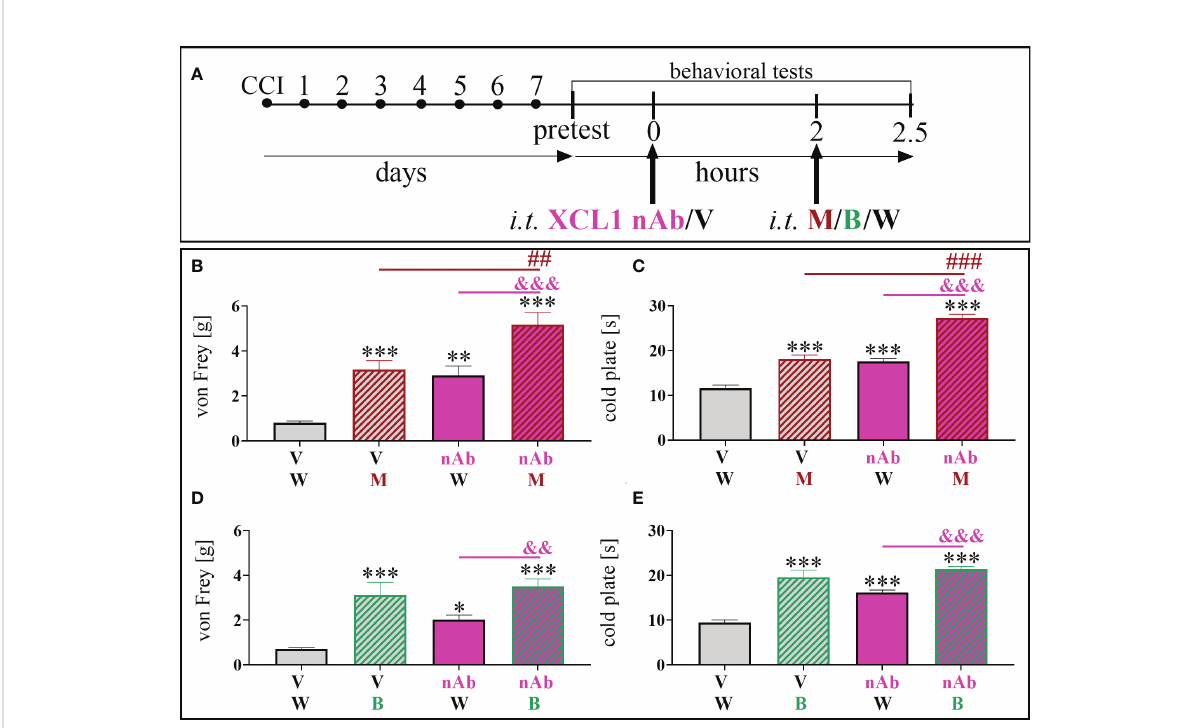
FIGURE 3 The in fl uence of a chemokine-C-motif ligand 1 (XCL1) neutralizing antibody (nAb) (B – E) at a dose of 8 m g/5 m l on morphine (M) 2.5 m g/5 m l (B, C) and buprenorphine (B) 2.5 m g/5 m l (D, E) effectiveness, administered according to scheme (A) , 7 days after chronic constriction injury (CCI) of the sciatic nerve in mice. The data are presented as the mean ± SEM (n =6). The results were evaluated using one – way ANOVA followed by Bonferroni ’ s post hoc test for comparisons of selected pairs. ✽ p<0.05; ✽✽ p<0.01; ✽✽✽ p<0.001 indicate signi fi cant differences between the V +W – and M – /B – /nAb – treated groups; ## p<0.01; ### P < 0.001 indicate signi fi cant differences between the M – and M+nAb – treated groups; && p<0.01; &&& P < 0.001 indicate signi fi cant differences between the nAb – and M+nAb – /B+nAb – treated groups. “ V ”– vehicle (PBS); “ W ” – vehicle (water for